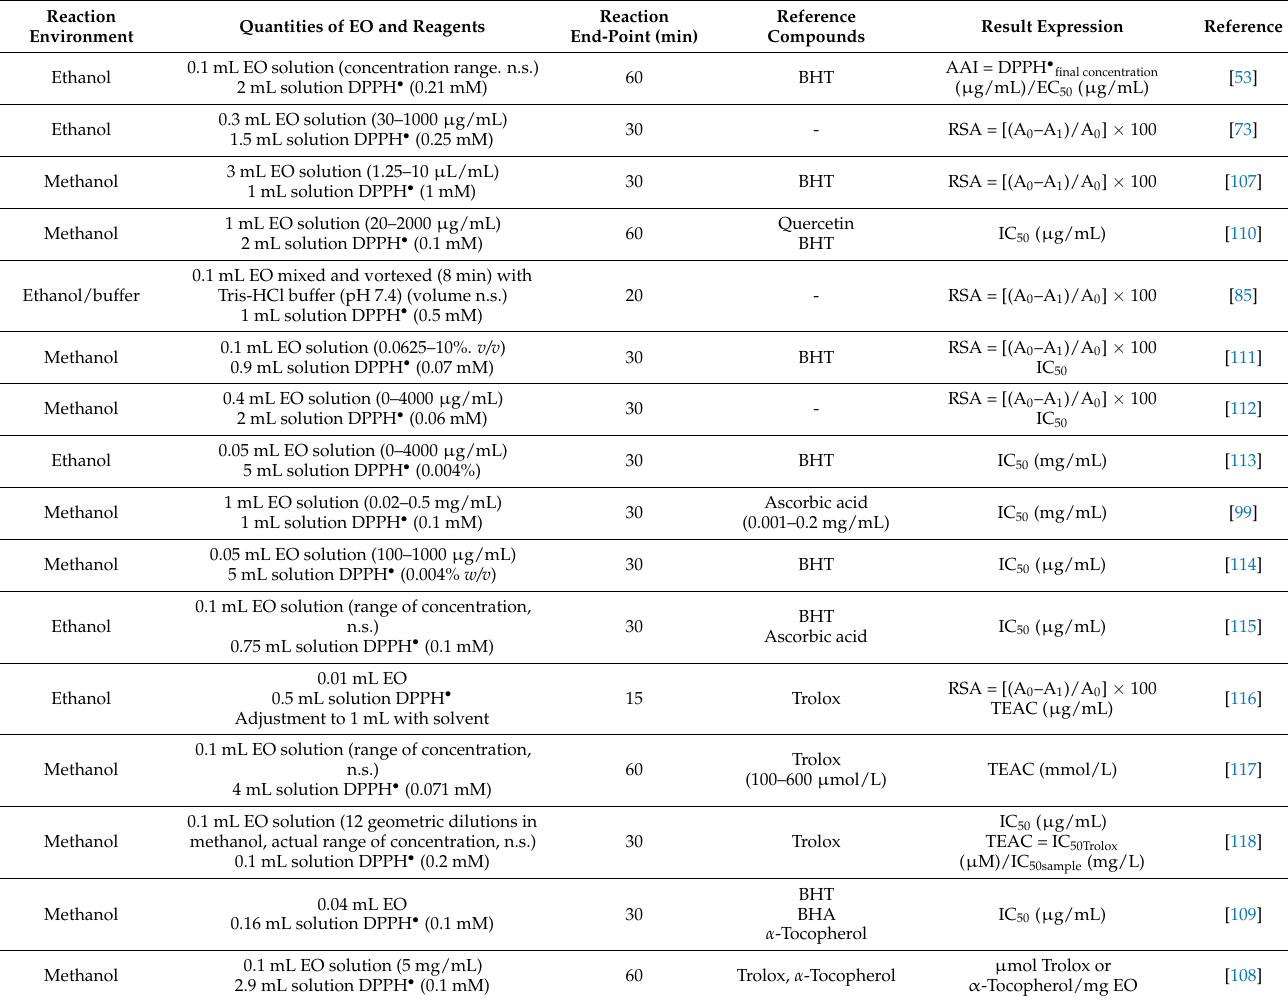
Table 6. Brief description of DPPH • protocols used for the evaluation of bay laurel EOs antioxidant activity in chronological order, since